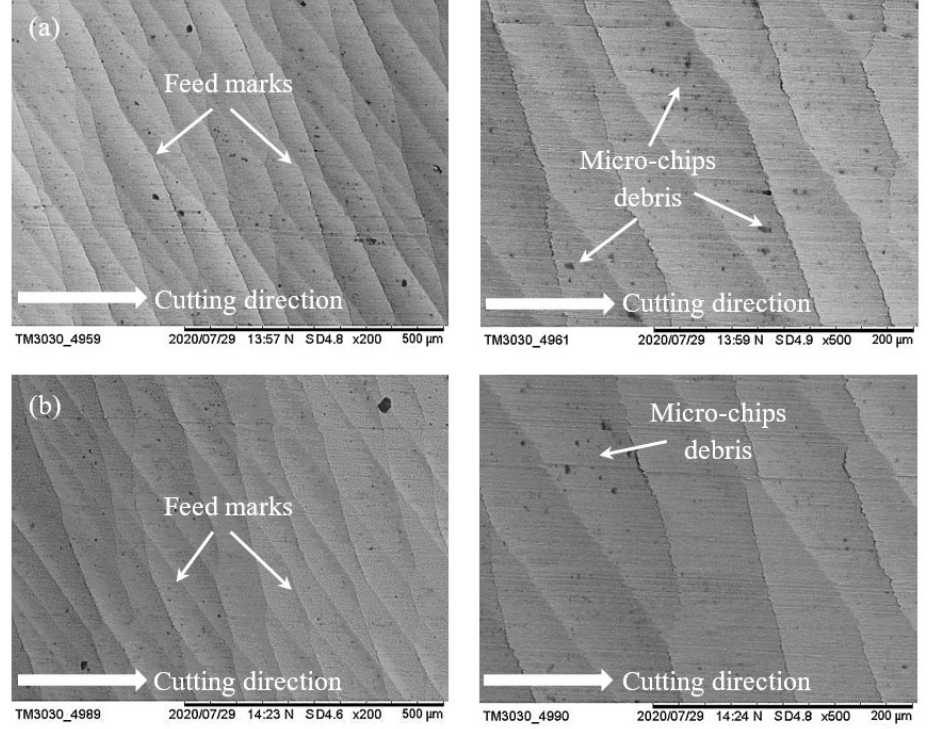
Figure 8. SEM micrographs of surface morphology at parametric combinations of n = 18,200 rpm, f = 400 mm/min and P = 600 mW; ( a ) conventional cutting fluid and ( b ) water ‐ soluble sago starch cutting fluid.